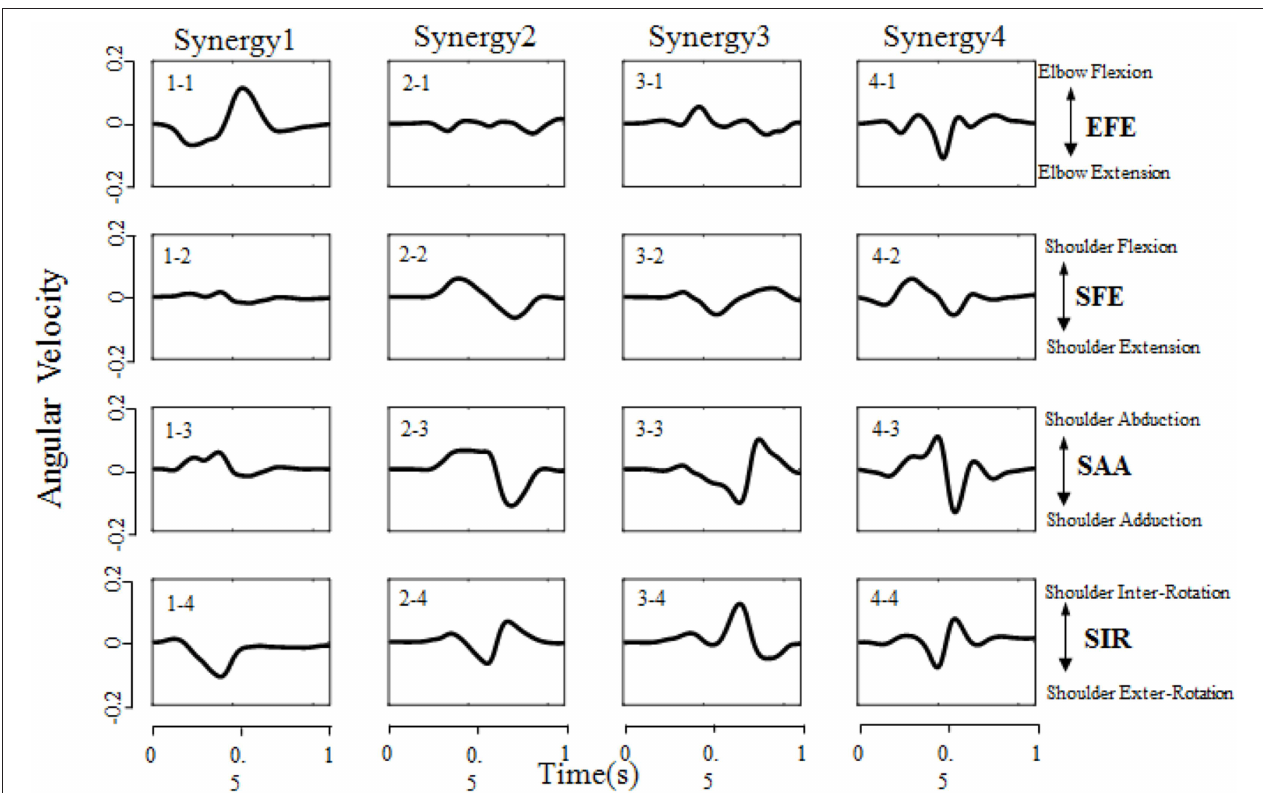
FIGURE 5 | Angular velocity profile based on the first four synergies of subject 9 performing the task of reaching target “e” (target location was illustrated in Figure 2B ). Each column corresponds to a specific synergy which have a duration time of 1 second (x-axis), and each row corresponds to a DoF (EFE, SFE, SAA, and SIR, respectively). The Positive/Negative angular velocity amplitudes (y-axis) indicates the movements of elbow flexion/extension (EFE), shoulder flexion/extension (SFE), shoulder abduction/adduction (SAA), and shoulder internal/external rotation (SIR),